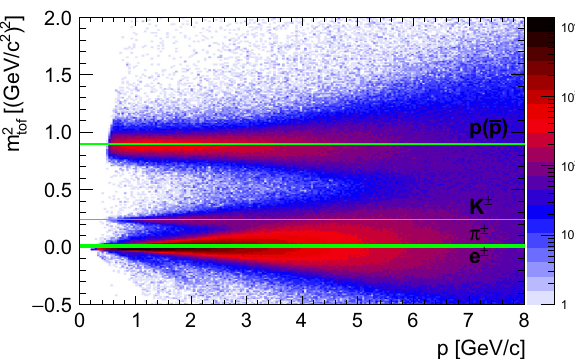
Fig. 13 Amasssquareddistributionofselectedtracks,calculatedfrom the tof measurements, as a function of particle momentum. Known squared masses of π ± , K ± , e ± and p (p) are overlaid on top were used to reduce the large variability in the statistical uncertainty for low and high momenta. The appropriate size of the bins was estimated from Fluka2011 .2c.5